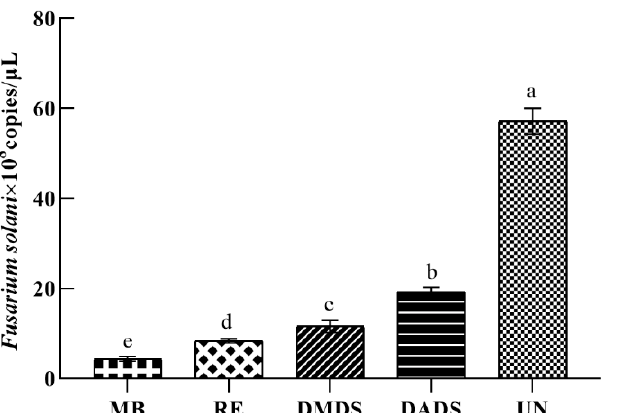
Figure 8. Effect of sulfur compounds and the root exudates of A. fistulosum L. on the abundance of the Fusarium solani isolate HBH 08. MB, replanted soil fumigated with methyl bromide; DMDS, replanted soil treated with dimethyl disulphide; DADS, replanted soil treated with diallyl disulphide; RE, replanted soil treated with root exudates; and UN, untreated replanted soil (control). Different letters (a, b, c, and d) indicate statistically significant differences according to Tukey’s HSD test ( p ≤ 0.05).